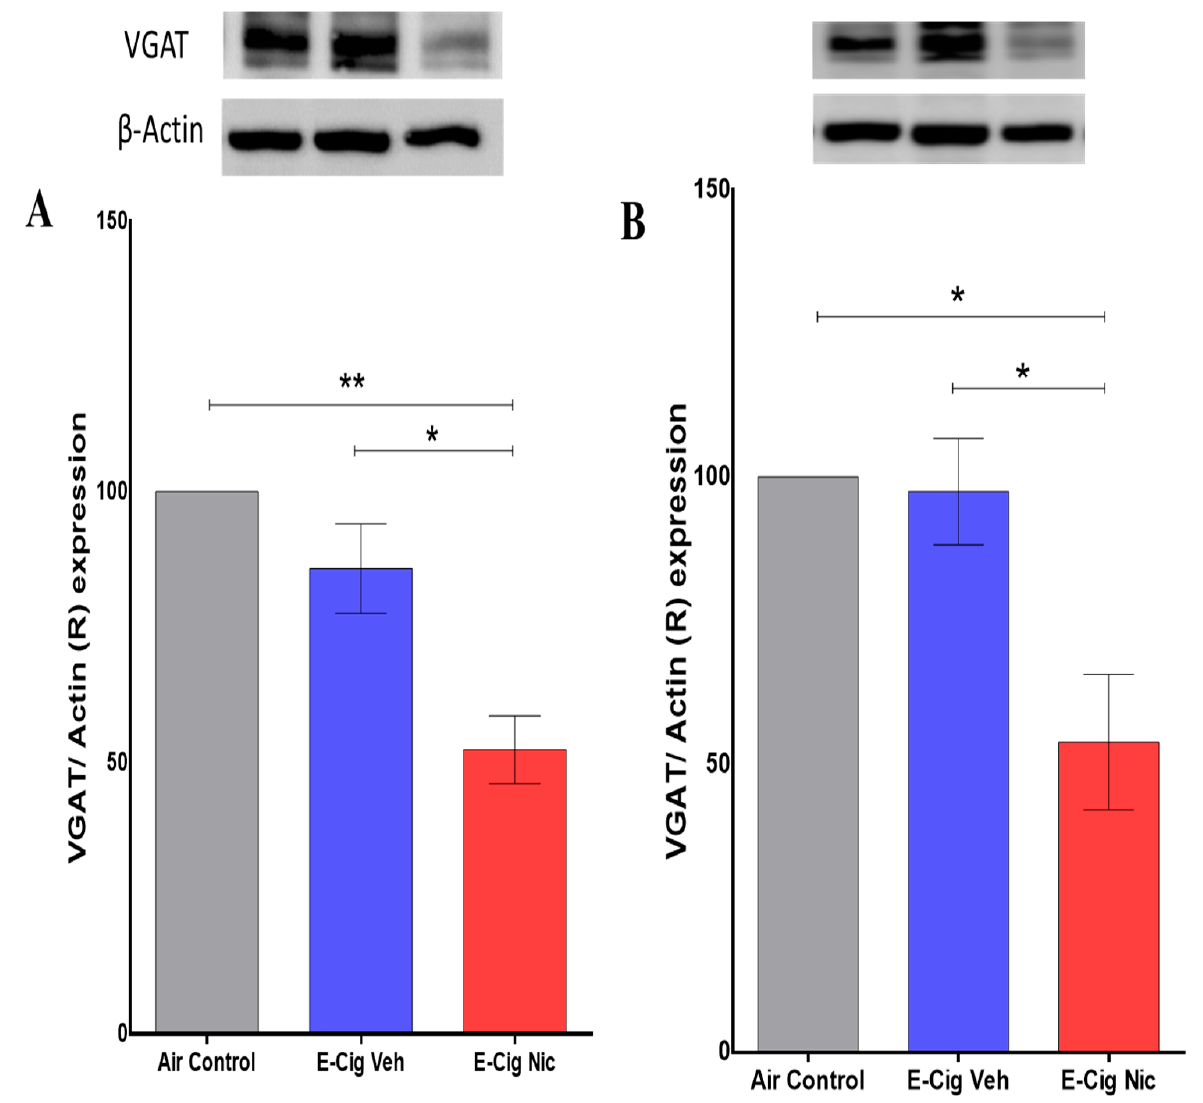
Figure 8. Relative (R) expression of VGAT in the hippocampus following four-week inhalation of e-cigarette vapors containing nicotine. ( A ) Representative VGAT expression blots in males of all three groups (upper panel) and corresponding quantitative statistical analysis (lower panel). ( B ) Representative VGAT expression blots in females of all three groups (upper panel) and corresponding